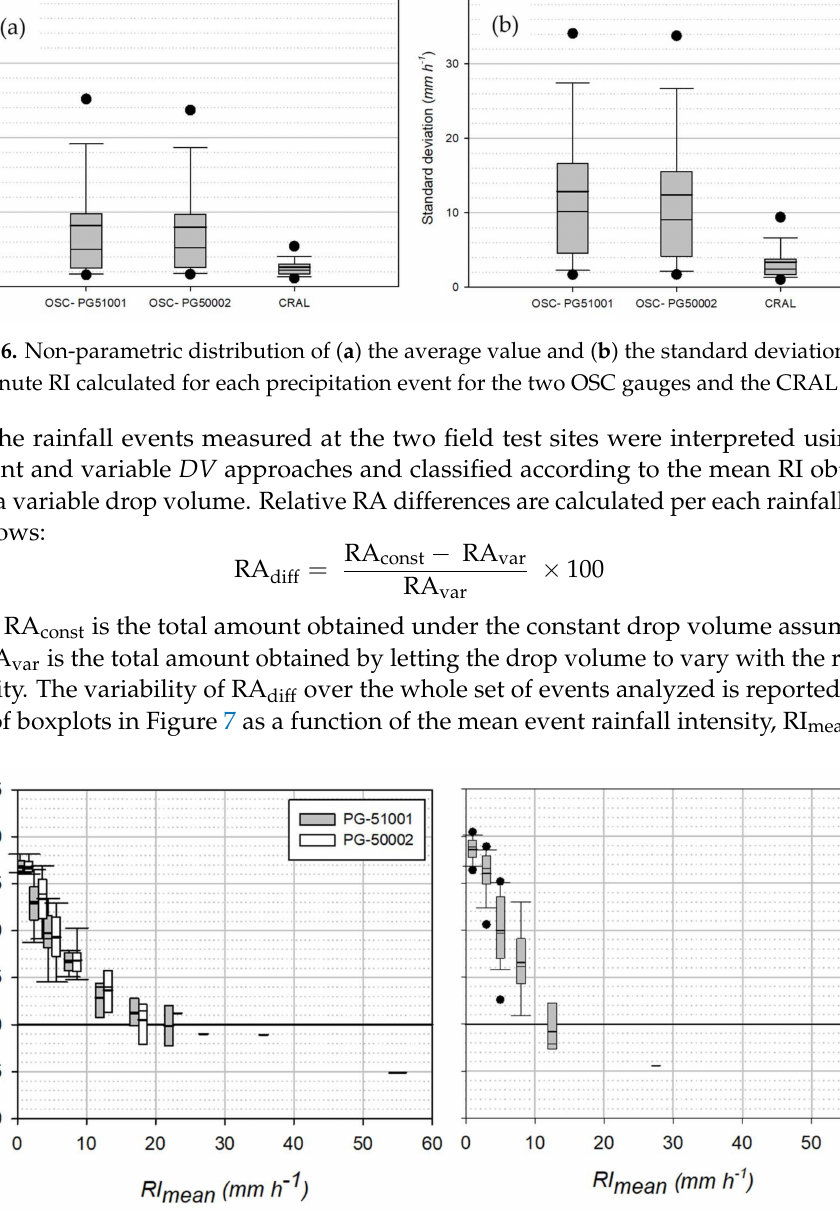
Figure 7. Non-parametric distribution of the relative difference between the total rainfall event amounts (RA diff ) obtained under the constant and variable drop volume assumption, as a function of RI mean for ( left ) the OSC gauges (at HKIA) and ( right ) the CRAL gauge (at